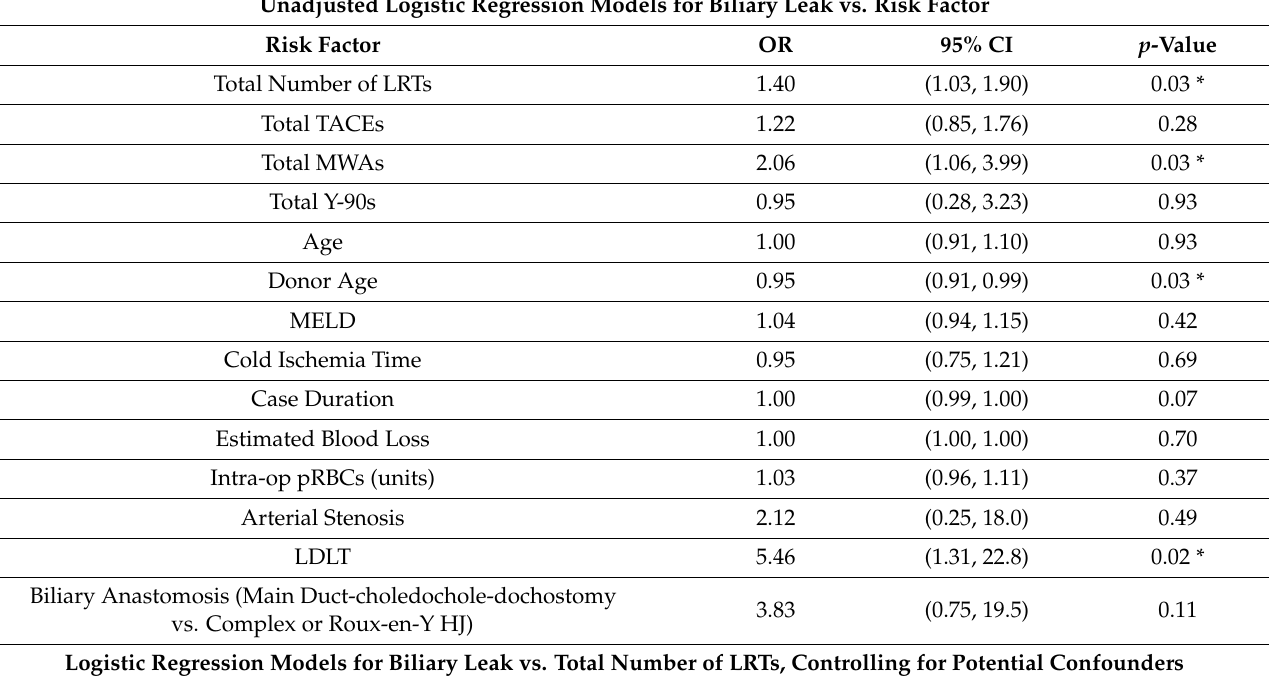
Table 5. Logistic Regression Models for Biliary Leak. Unadjusted Logistic Regression Models for Biliary Leak vs. Risk